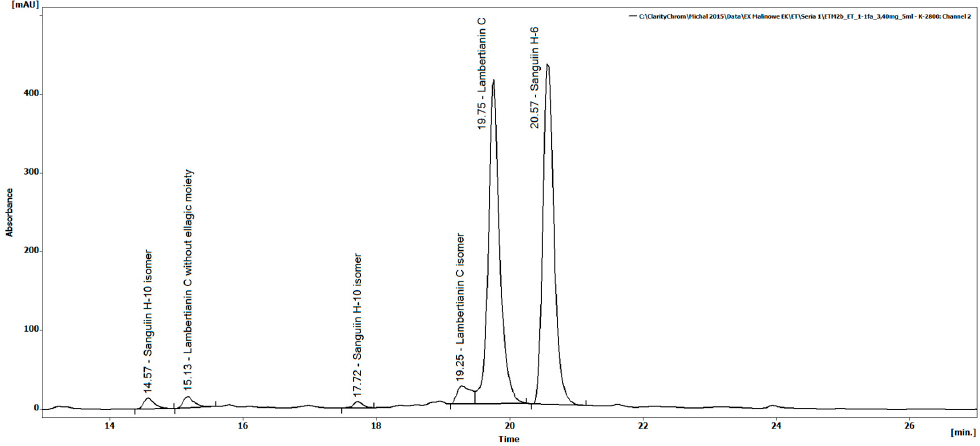
Figure 1. HPLC chromatogram of the raspberry ellagitannin preparation (REP) with UV detection at 250 nm. Table 2. Ellagitannin (REP), anthocyanin (ACY), and flavanol (FLAVA) content in raspberry ellagitannin extract (REP).